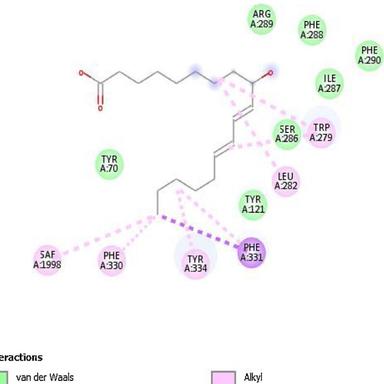
Putative interactions between hydroxyoctadecadienoic acid and acetylcholinesterase (Protein Data Bank (PDB): 1JQR). Free energy of binding (-G) and affinity (Ki) are -5.9 kcal/mol and 48 M, respectively.